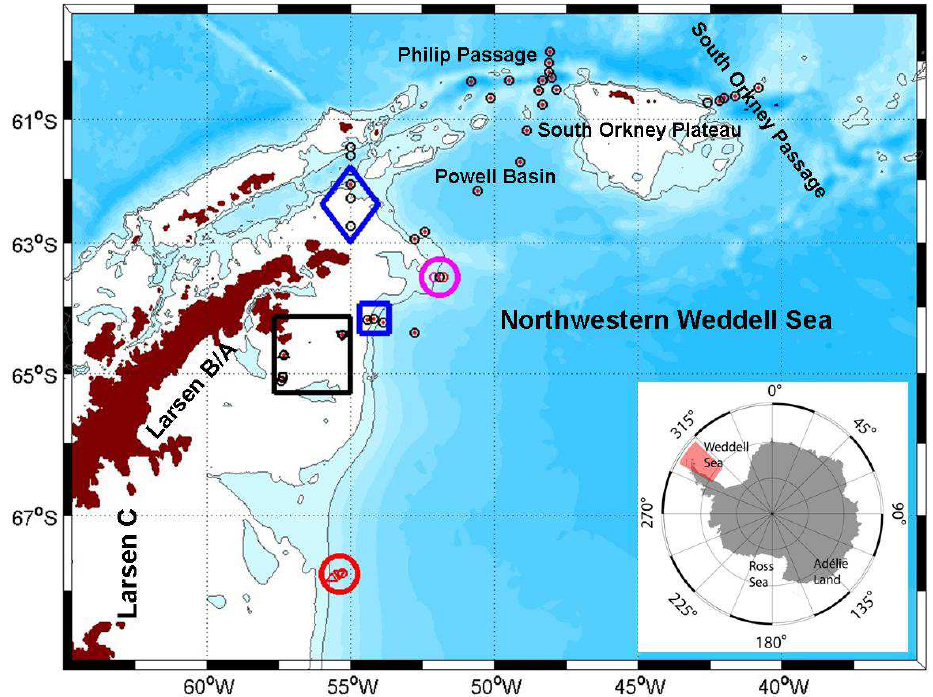
Fig. 2. Station distribution of austral winter cruise AW 06 to the northwestern Weddell Sea differentiated by profiles with noble gas measure- ments (red dots) and CFC measurements (black open circles). The black square (with triangles, square, and circle) encloses stations which provide the neon values (Fig. 4), GMW fractions (Fig. 5), and CFC-12 values (Fig. 7). The blue diamond (blue square) borders stations which provide the CFC-12 profiles, displayed as “x” (“+”) in Fig. 7. The magenta circle surrounds stations from previous summer cruises for which the neon profiles are displayed in Fig 10. In addition, the red circle (including triangles and circle) encloses AS 04 (ISPOL) stations which provide the neon values added to Fig. 4. The thin grey lines represent the 500-m and 1000-m isobaths.